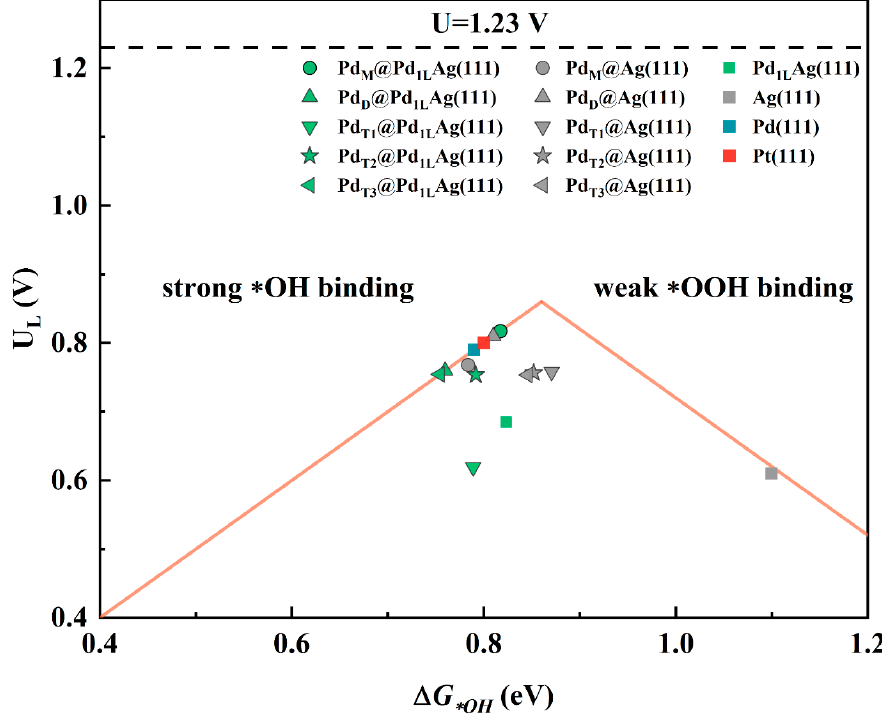
Figure 5. Volcano plot of the limiting potential for the ORR analyzed by results from the thermody- namic analysis. The black dashed line is the equilibrium potential for the ORR.